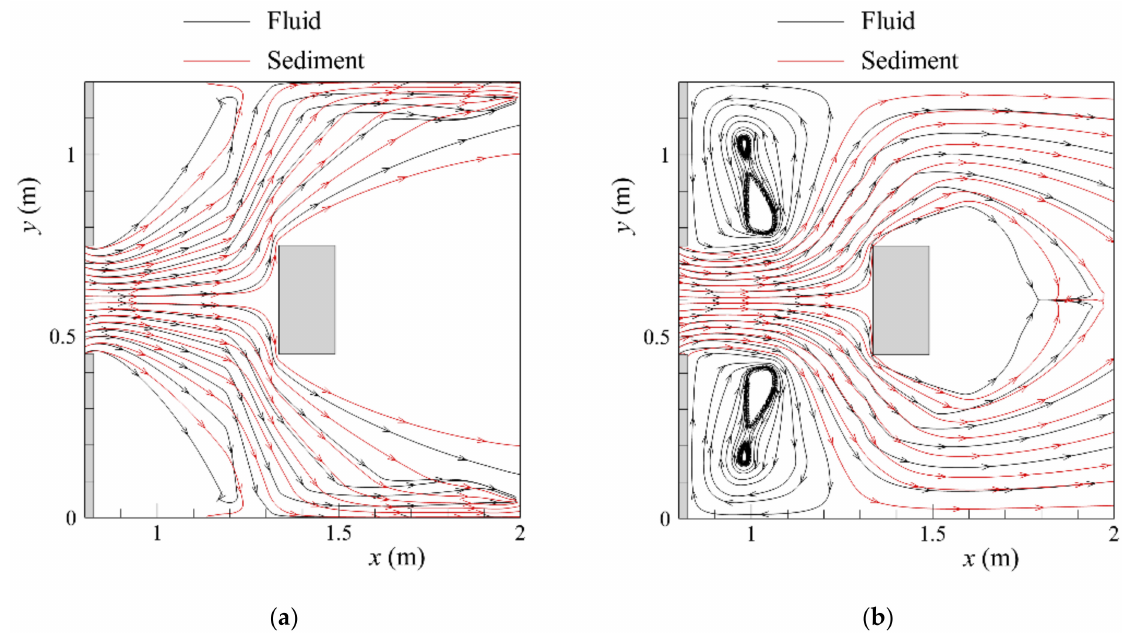
Figure 12. Fluid (black) and solid (red) streamlines predicted by the two-phase model for PVC particles with d = 5 × 10 − 4 m: ( a ) at t = 1.5 s; ( b ) at t = 3.0